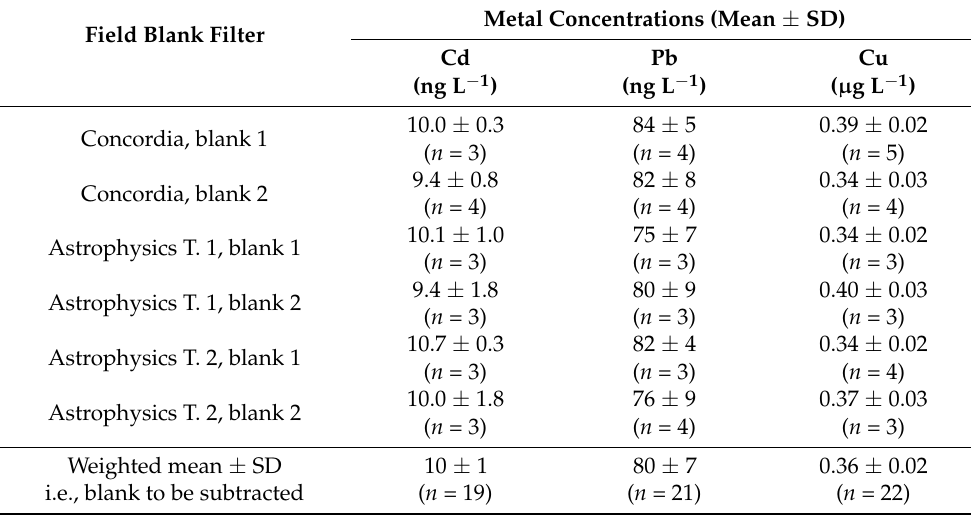
Table 7. Blank values obtained analyzing the field blank filters for Cd, Pb, and Cu. Conditions: 1/8 filter, 100 mL final solution after digestion. Blanks include laboratory blanks (a sort of filter blanks gross of laboratory blanks); thus, they represent the blanks to be